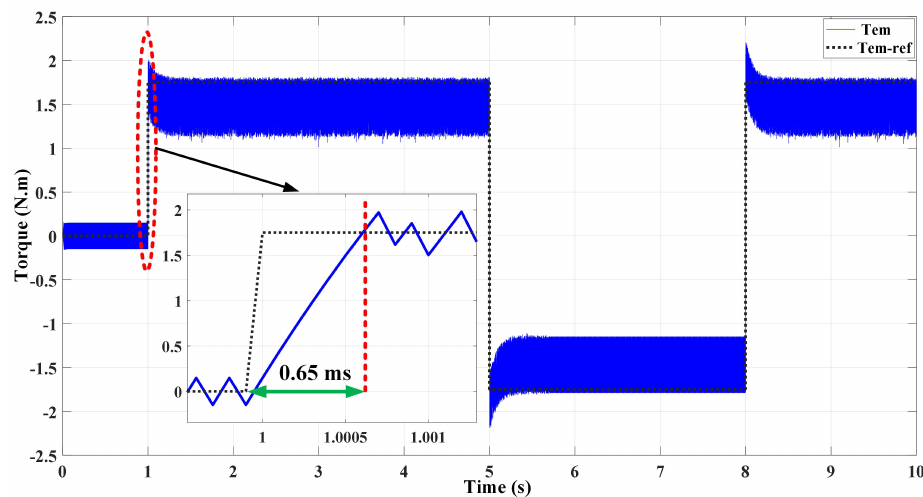
Figure 16. Torque response of the proposed strategy for nominal speed.